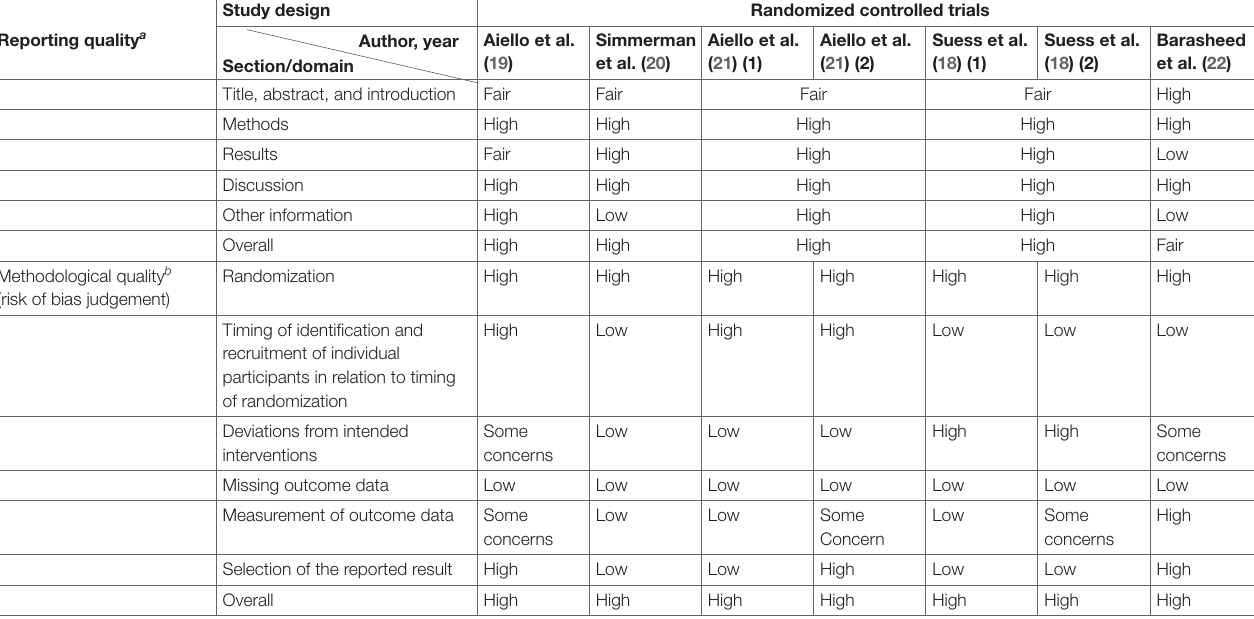
TABLE 3 | Summary of reporting and methodological quality of randomized controlled